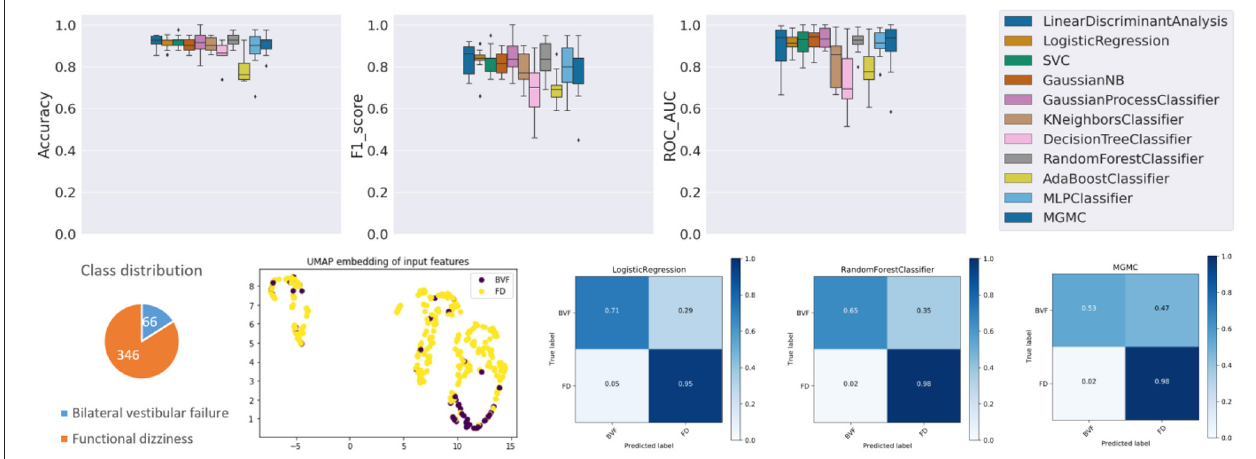
FIGURE 2 | Results panel produced by base-ml for Task 1. It comprises: boxplots for the three classification metrics, accuracy, f1-score and ROC-AUC; a pie chart to highlight potential class imbalances for this task; the UMAP 2D embedding of all patients’ input feature vectors; and a more detailed overview of classification outcomes in form of confusion matrices, for three classifiers, LR, MGMC and